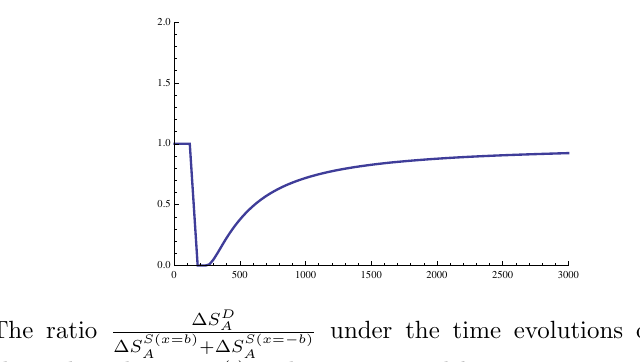
Figure 36 . The ratio under the time evolutions of HEE in the